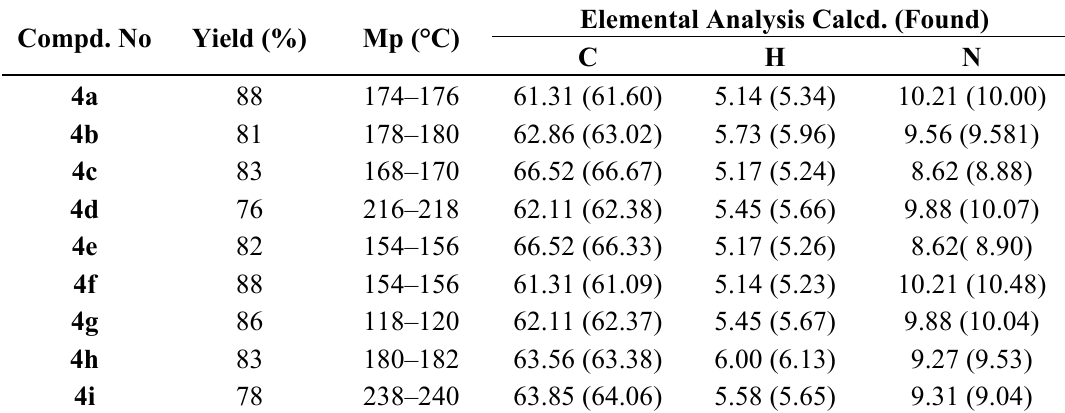
Table 2. Yield (%), Mp (°C), and Elemental analysis of 4a – i